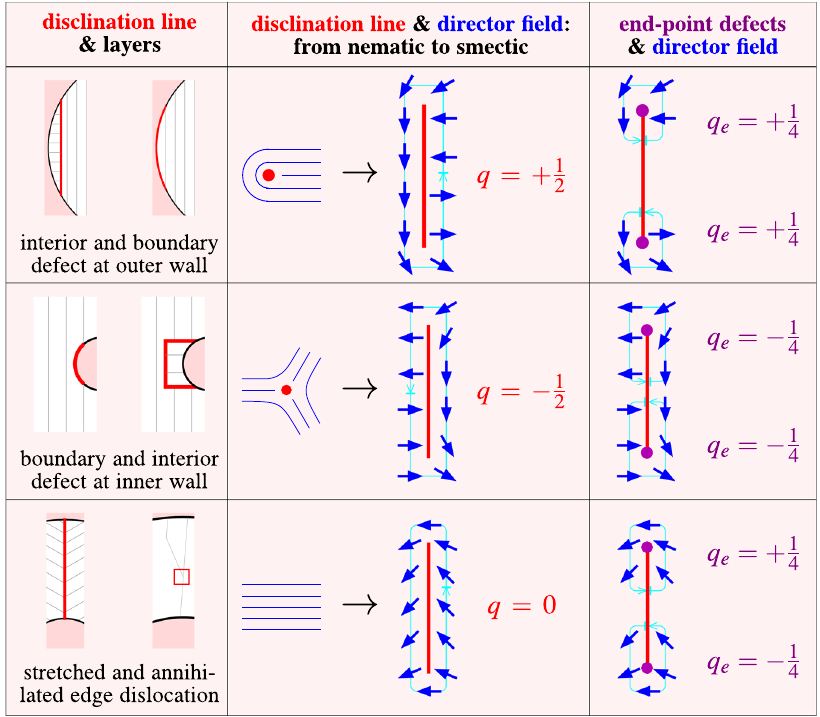
Fig. 5 Topological defects in con fi ned smectics. The anti-radial line disclinations at the outer (top row) and inner (middle row) wall are located in the interior or attached to the boundary. The radial line disclinations are topologically equivalent to edge dislocations (bottom row) and can be interpreted as a stretched or annihilated defect, respectively. Left column : schematic illustration as in Fig. 2. Middle column : orientational director fi eld (blue lines/arrows) around line defects (red) with topological charge q according to the drawn closed integration path (cyan circular arrow). The disclination lines can be interpreted as stretched nematic point defects, shown for comparison. Right column : director fi eld at the end-point defects (violet) of disclination lines with charges q e . Here the integration path is not closed but rather begins and ends on two sides of the disclination.